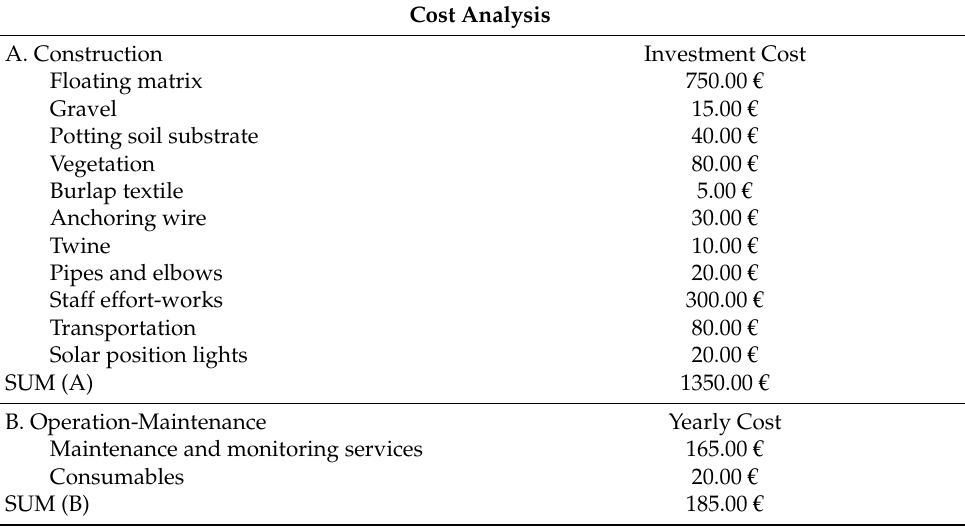
Table 6. Cost analysis of the FW system construction and